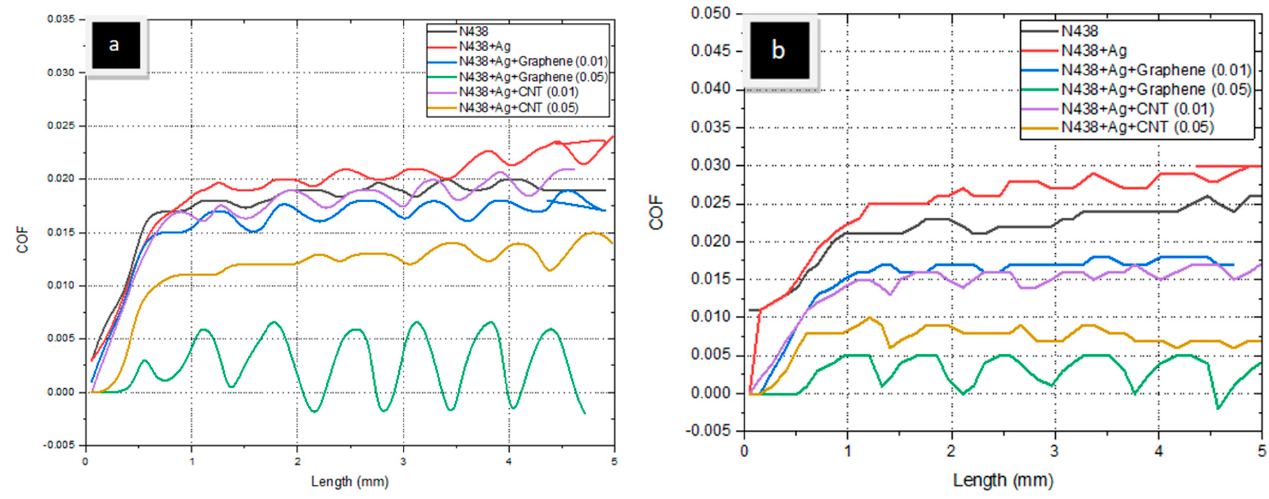
Figure 6. Coefficient of Friction at ( a ) 2N and ( b ) 3N.